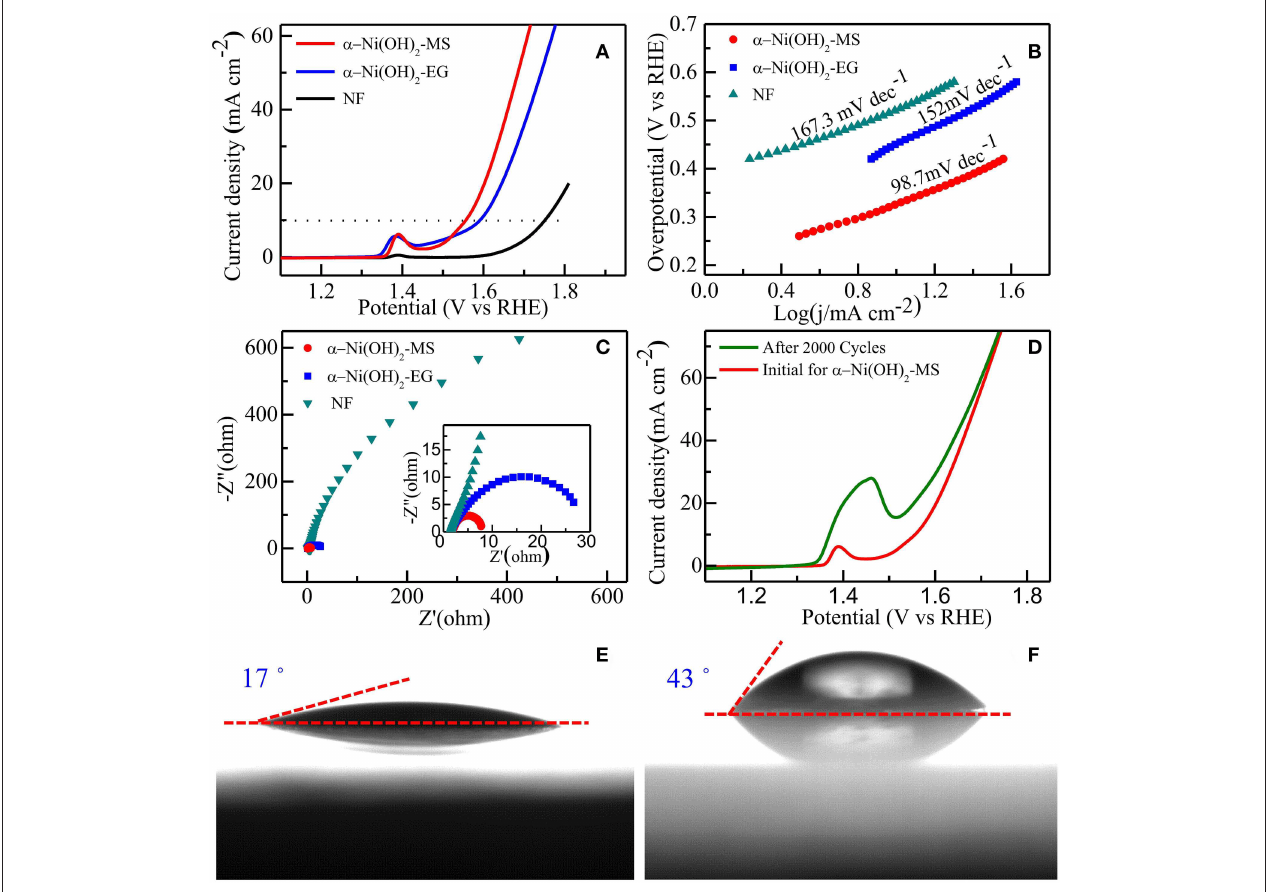
FIGURE 6 | (A) LSV curves without iR drop compensation of α -Ni(OH) 2 -MS, α -Ni(OH) 2 -EG, and bare NF. (B) Corresponding Tafel plots. (C) EIS Nyquist plots of the samples. The inset shows corresponding Nyquist plot at high frequency range. (D) OER LSV curves of α -Ni(OH) 2 -MS before and after 2,000 CV cycles. Contact angle measurements of (E) α -Ni(OH) 2 -MS, and (F) α -Ni(OH) 2 -EG.